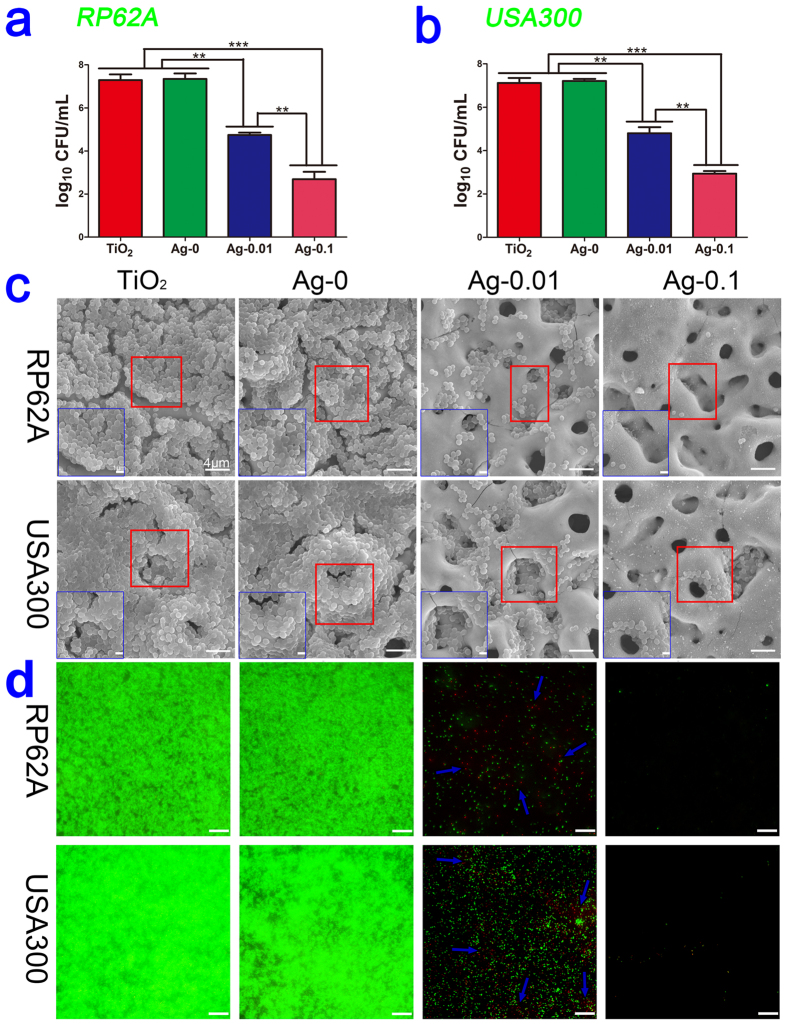
Antibacterial capability against sessile bacteria in vitro at the end of the experiment.Subfigures (a) and (b) present the quantitative antibacterial effects on the CFU value on the samples for RP62A and USA300, respectively. Significantly decreased CFU/ml counts of adherent bacteria were observed. **P < 0.01, ***P < 0.001. Subfigure (c) shows the SEM morphologies of the two types of biofilms on four specimen surfaces. The inner blue box corresponds to ×10000 magnification. The outer large box corresponds to ×3000 magnification. Subfigure (d) shows projected top views of the two types of biofilms on four sample surfaces obtained via CLSM at ×400 magnification. The scale bar represents 25 μm. The blue arrows indicate red fluorescence in the images.